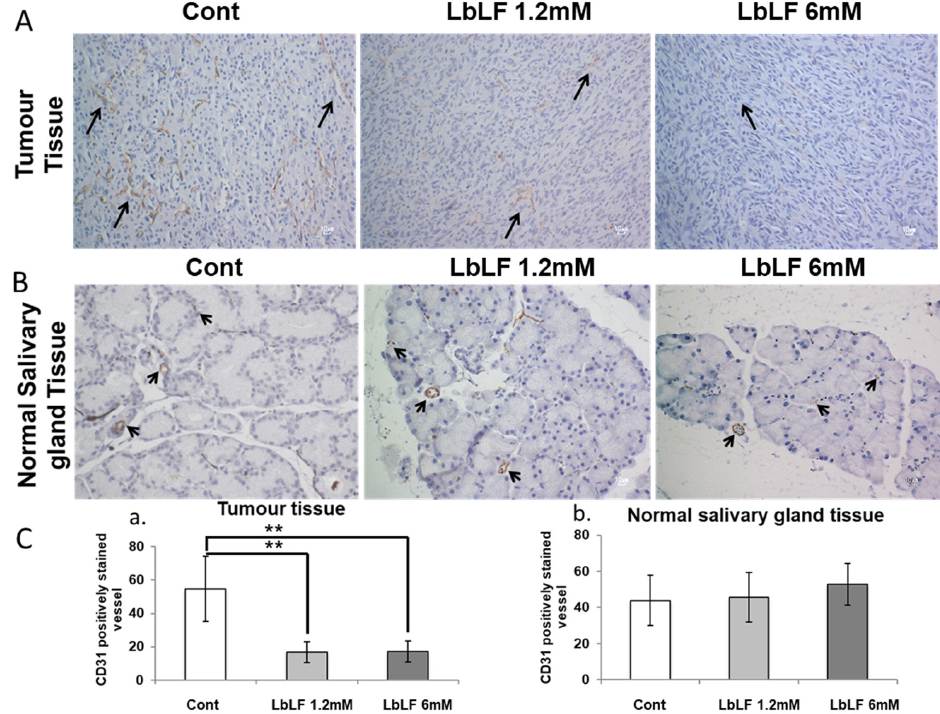
Figure 6. CD-31 immunohistochemical staining in tumor and surrounding salivary gland tissues. ( A ) Transplanted oral squamous cell carcinoma cell (OSCC) tissue. ( B ) Salivary gland. Black arrows show CD-31-positive capillaries. ( C ) Number of CD-31-positive capillaries in tumor tissue ( a ) and normal salivary gland tissue ( b ). Data represent the mean ± standard deviation (SD). Statistical significances were determined by one-way analysis of variance (ANOVA). ** p < 0.01.